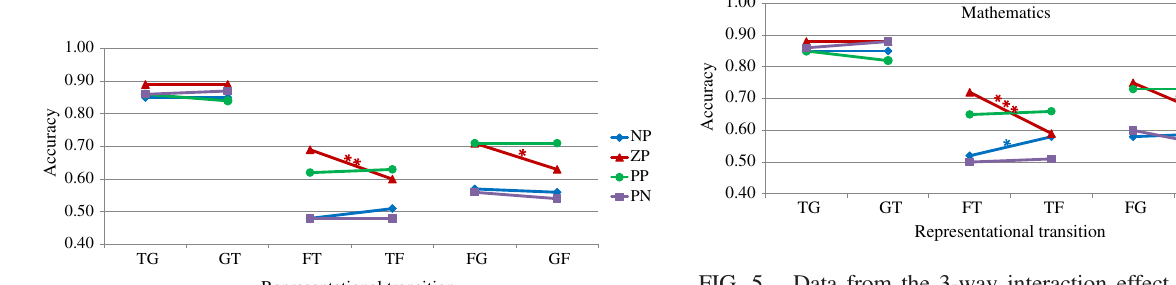
FIG. 5. Data from the 3-way interaction effect of representa- tional transition (TG, GT, FT, TF, FG, and GF), function type (NP, ZP, PP, and PN) and context for the context of mathematics. The data points connected by lines represent the pairs of transitions which are each other ’ s opposite. The p value of the comparisons is indicated by * for p < 0 . 05 , ** for p < 0 . 01 , *** for p < 0 . 001 . In the mathematics context there are three significant asymmetries: for the ZP function type there is one between FT and TF transitions with p < 0 . 001 and one between FG and GF transitions with p < 0 . 001 ; for NP there is a significant asymmetry between FT and TF with p < 0 . 05